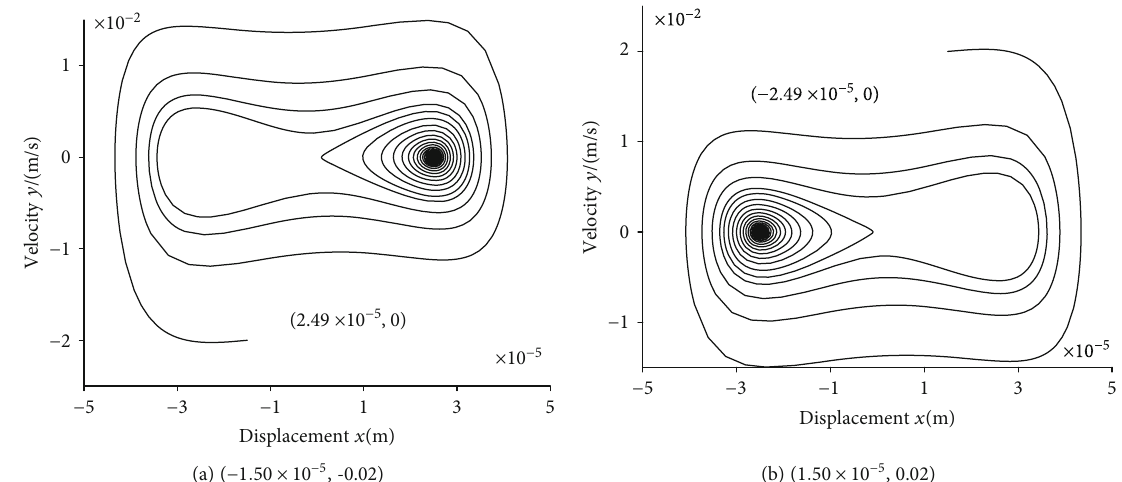
Figure 34: Phase trajectories under h